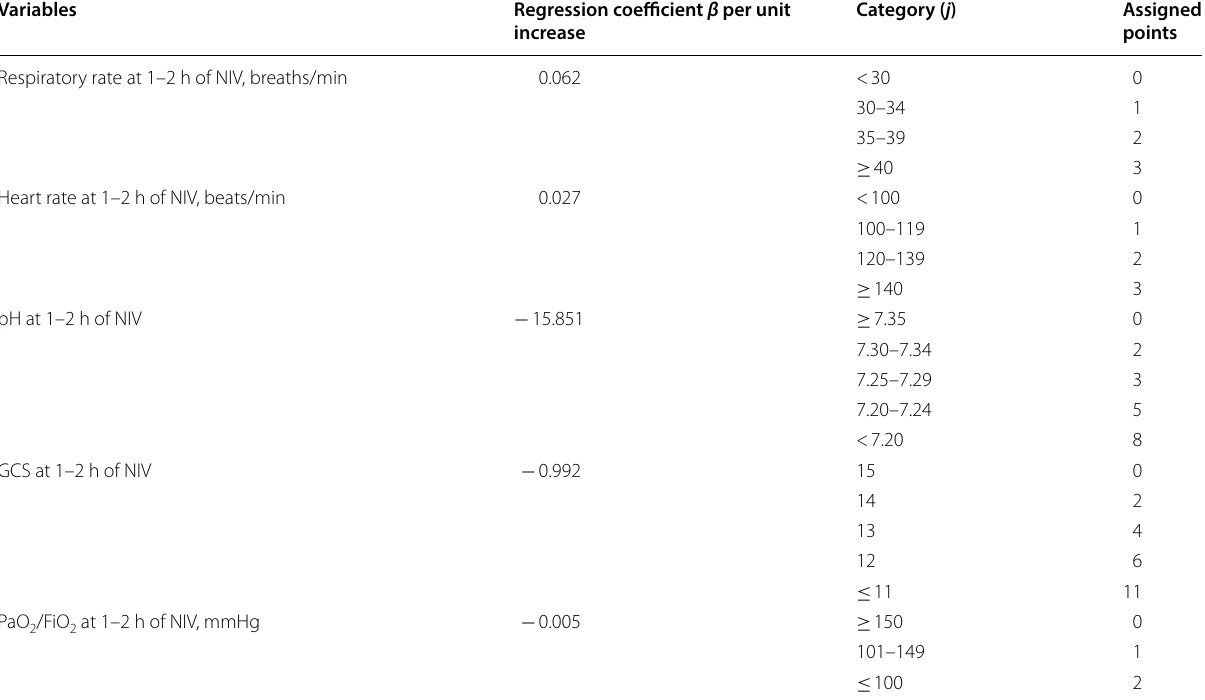
Table 3 Final model for prediction of NIV failure in the derivation cohort and points assigned to each